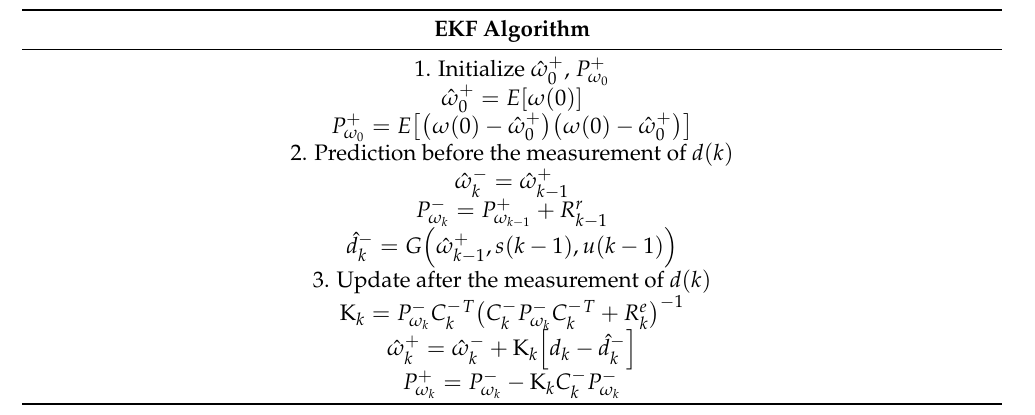
Table 5. EKF for VDPs estimation.